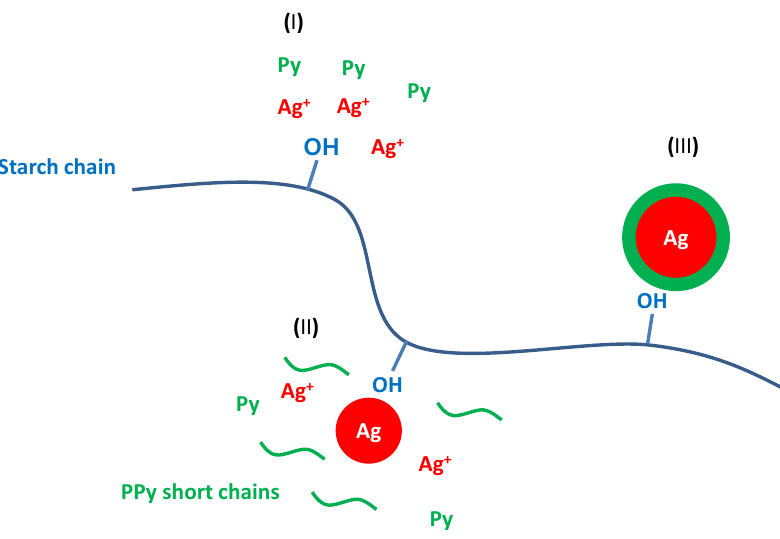
Figure 9. ( a ) Photograph showing the flexibility of a large-area, free-standing PPy/cellulose (PPCL) paper; ( b ) SEM images of a PPCL paper (inset: high-magnification image). With permission from [65]; Copyright 2014, The Royal Society of Chemistry.